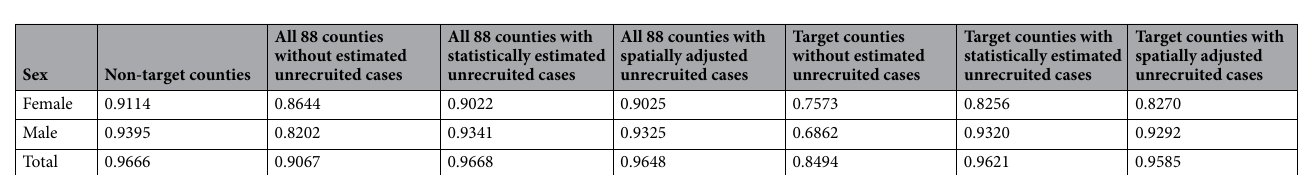
Table 3. Pearson’s correlation coefficients ( r ) between county-level ALS case count and ALS mortality count in